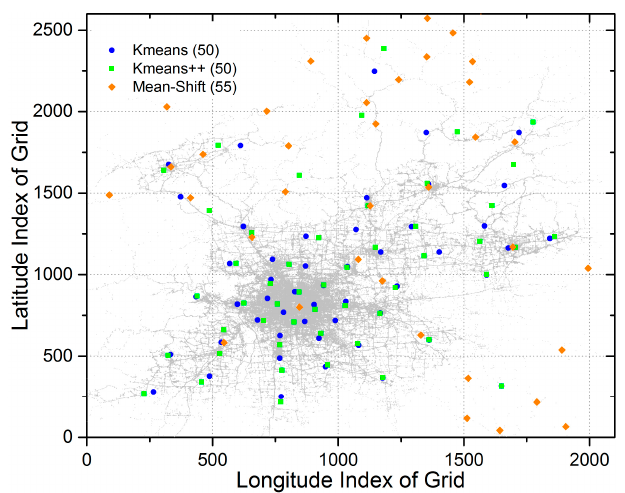
Figure 7. Final locations of data centers with different clustering algorithms.